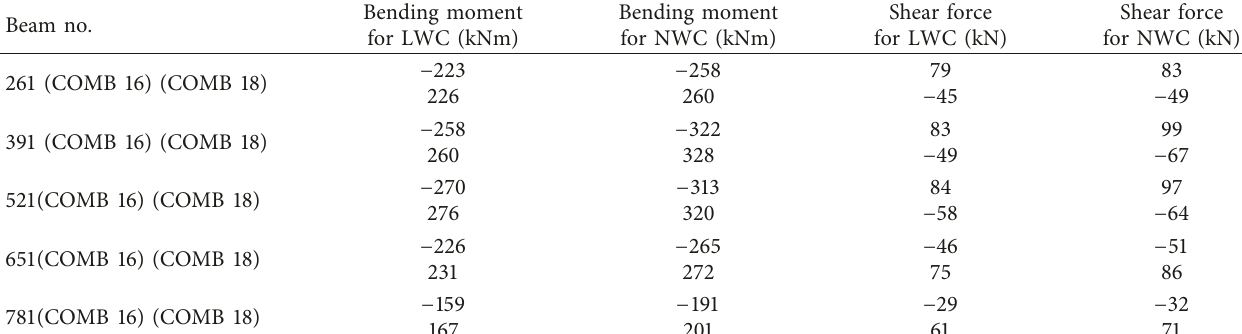
Table 4: Bending moments and shear